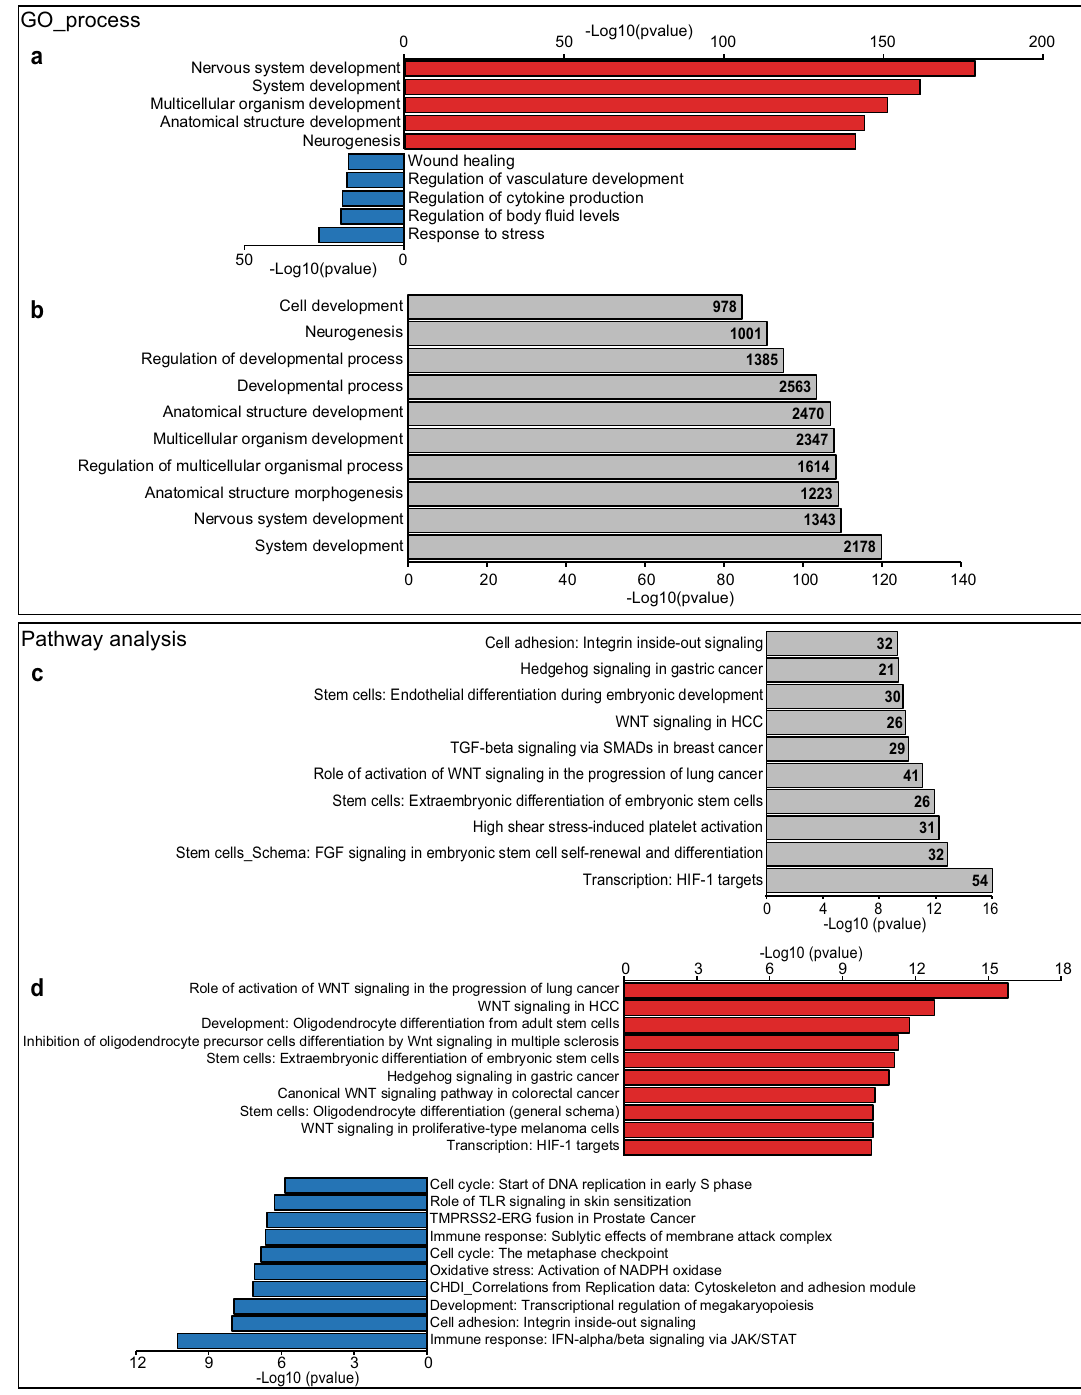
Figure 2. GO analysis identifies nervous system development and response to stress as the processes with the greatest number of DEG that were higher or lower in PVEC vs. ABEC. ( a ) Gene Ontology (GO) analysis using the Metacore from Clarivate Analytics identified the top 5 most enriched biological process when separated by higher (red) or lower (blue) differentially expressed genes (DEG) in PVEC vs. ABEC. ( b ) The top 10 more enriched biological processes when all DEG were analyzed together closely resembles the analysis performed using DEG that were higher in PVEC vs. ABEC. Numbers inside the bars correspond to the number of DEG in each given GO biological process. ( c ) Canonical pathway enrichment analysis using the Metacore identified the top 10 most enriched pathways in PVEC vs. ABEC, here depicted as grey bars. Numbers inside the bars correspond to the number of DEG that were identified in each given pathway. ( d ) Canonical pathway enrichment using the Metacore, following partitioning of our data into genes that were higher (red) or lower (blue) in PVEC vs. ABEC identified the top 10 pathways in each